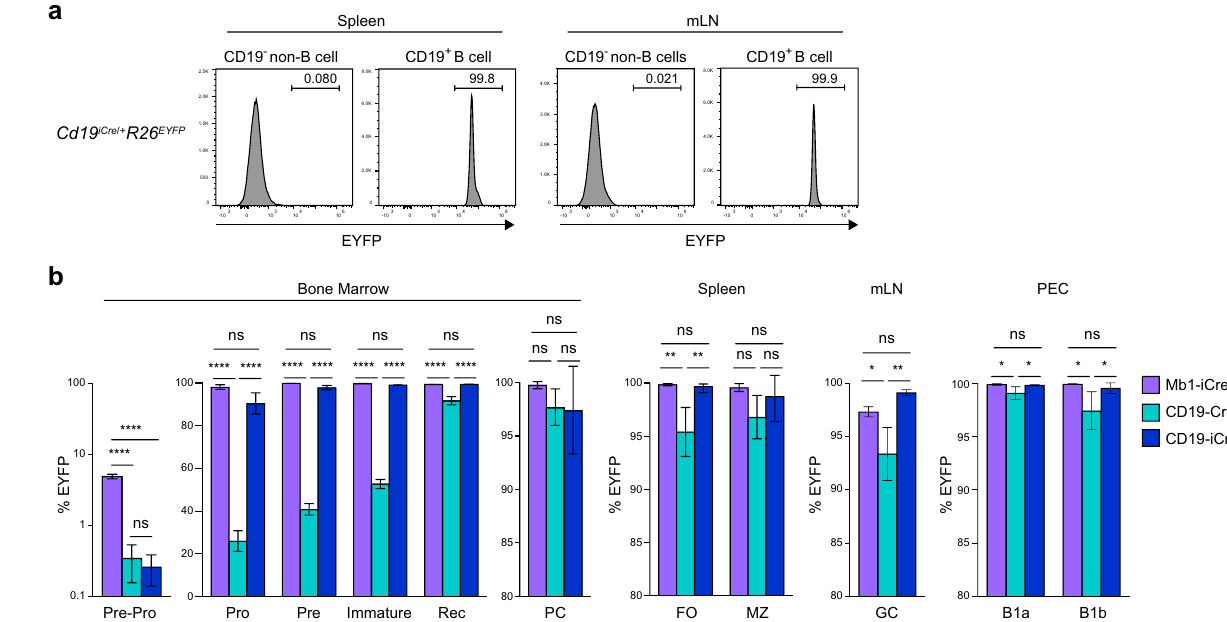
Figure 2. B cell-specific and efficient Cre-mediated recombination activity in CD19-iCre line. ( a ) EYFP expression is demonstrated in CD19 + B cells and CD19 - non-B cells from spleen and mLN of Cd19 iCre /+ R26 EYFP mice. ( b ) Flow cytometry analysis of EYFP expression by different B cell subsets (as defined in Fig. 1f), from bone marrow, spleen, peritoneal cavity (PEC), and mesenteric lymph node (mLN) of Mb1 iCre /+ R26 EYFP , Cd19 Cre /+ R26 EYFP , and Cd19 iCre /+ R26 EYFP mice. Data are representative of three independent experiments ( a ), or pooled from two independent experiments ( b ). Data are presented as mean ± SD. * P < 0.05; ** P < 0.01; *** P < 0.001; **** P < 0.0001; ns, not significant. The P values were obtained by one-way ANOVA with Tukey’s post hoc test ( b